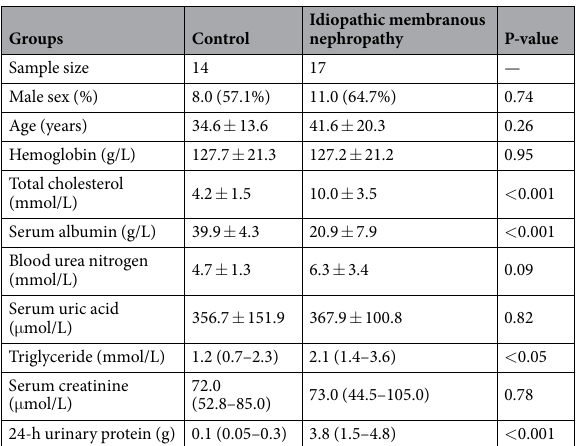
Table 1. Clinical characteristics of the enrolled